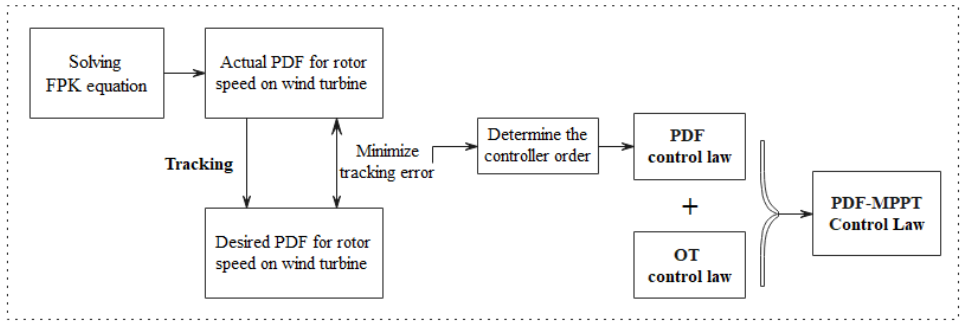
is marked as “PDF-MPPT control” in subsequent parts.